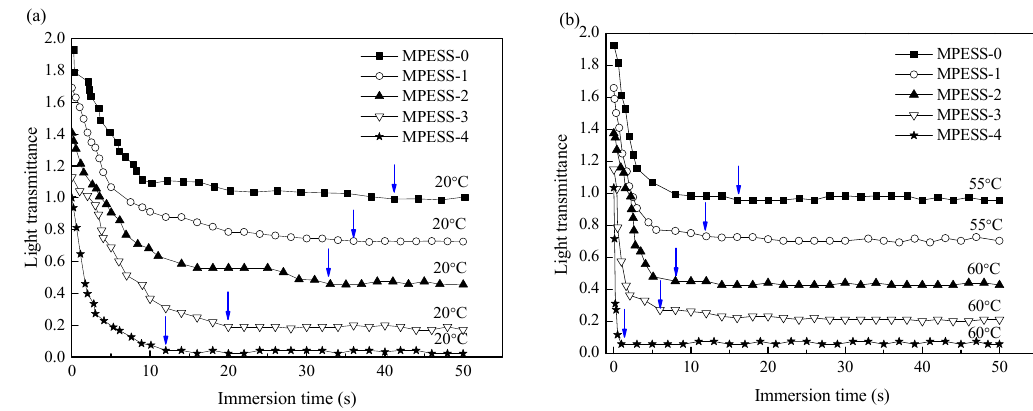
Figure 3. Light transmittance curve obtained by ( a ) NIPS and ( b ) Reverse Thermally Induced Phase Separation (RTIPS) mechanism. (Profiles are shifted for the purpose of clarity).